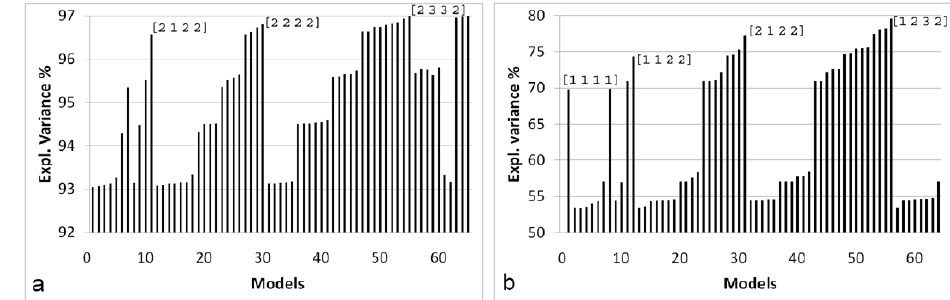
Figure 6. ( a ) Scree plot of the Tucker3 model applied on the four-way array 365 days × 16 years × 5 parameters × 3 sites; ( b ) Scree plot of the Tucker4 model applied on the four-way array 7 days of the week × 834 weeks × 3 sites × 5 parameters. The percentage of explained variance is reported in the Y